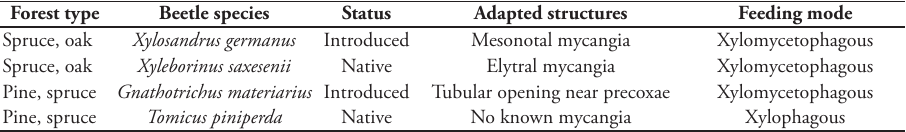
Table 1. Beetle species included in the study and relevant life history